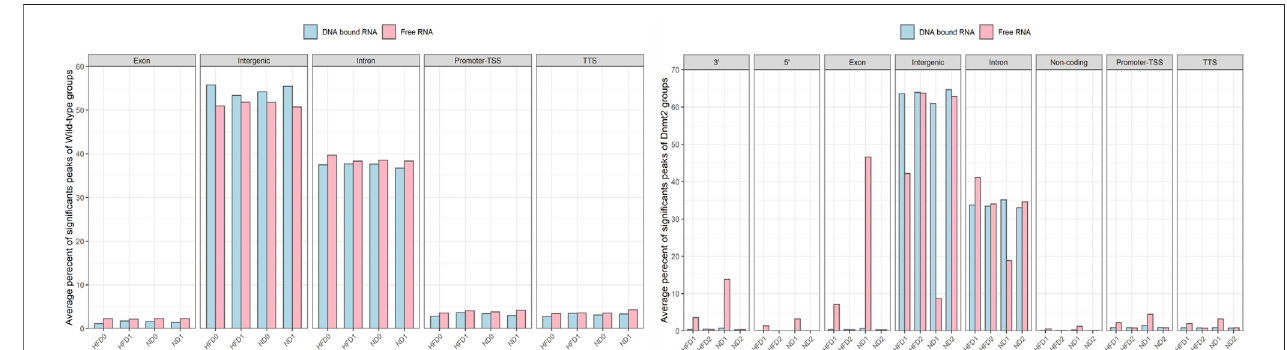
FIGURE 5 | Average percentage of signi fi cant peaks per genomic regions of RNA fractions (DNA bound and Free RNA) in spermatozoa from C57BL/6 and Dnmt2 − / − C57BL/6 maintainedinhigh-fatdiet(21%butter)andnormaldiet.TwoRNAfractions(DNA-boundandfree)arepreparedfromeachmale,fourwild-typeandfour Dnmt2 − / − C57BL/6 .Foreach group ofsamples,afraction corresponds totheRNAs released fromthe sperm during extraction inthe aqueous phase which wehavecalled thefreeRNAfraction.Anotherfractionisreleasedfromthepuri fi cationofgenomicDNAaftertreatmentwith Dnase whichwecallDNA-boundfractionRNA.Thetwo samples used as template for the RNA-seq analysis and the data were analyzed (see Methods). After obtaining sets of peaks, peak annotation was performed using Homer annotate peaks to relate each peak to nearby genes and genomic features. A false discovery rate (FDR) cut off 0.001 was used for identifying signi fi cant peaks. Thepositionsannotatedforpromoter-TSS,exons,introns,andotherfeatureswerebasedonthemm10transcripts.Malesonhigh-fatdiet(HFD)andnormaldiet(ND),as well as for Dnmt2